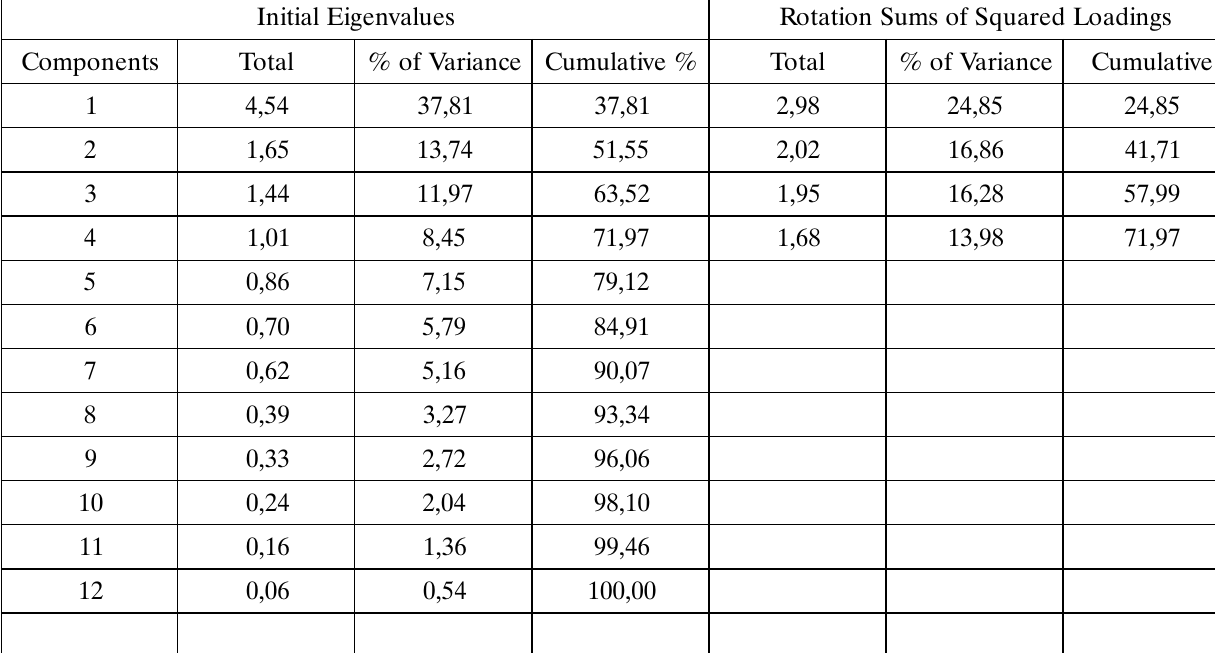
Table 6a . Rotated Solution – Information Sources